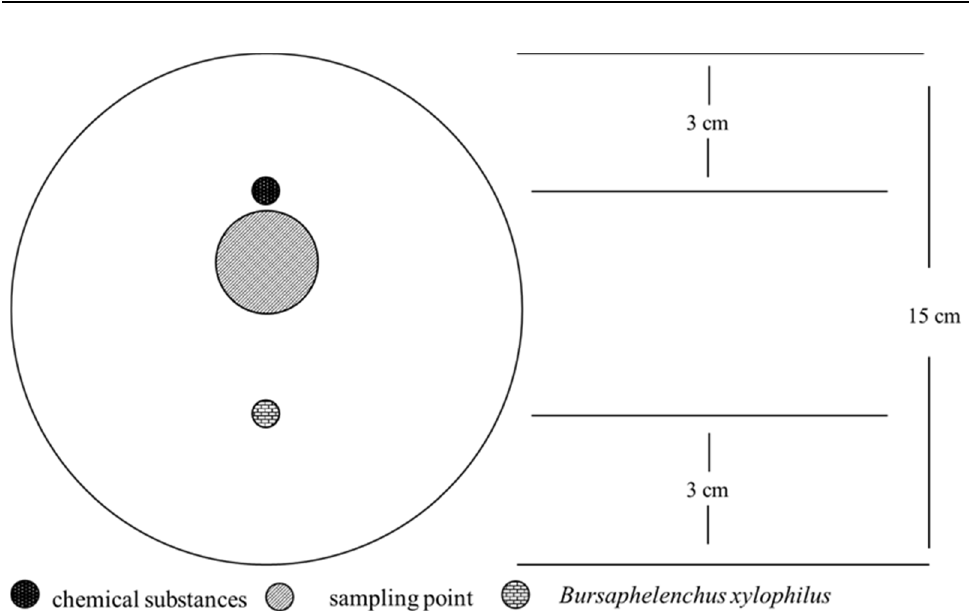
Figure 1. Schematic diagram of the plate attraction